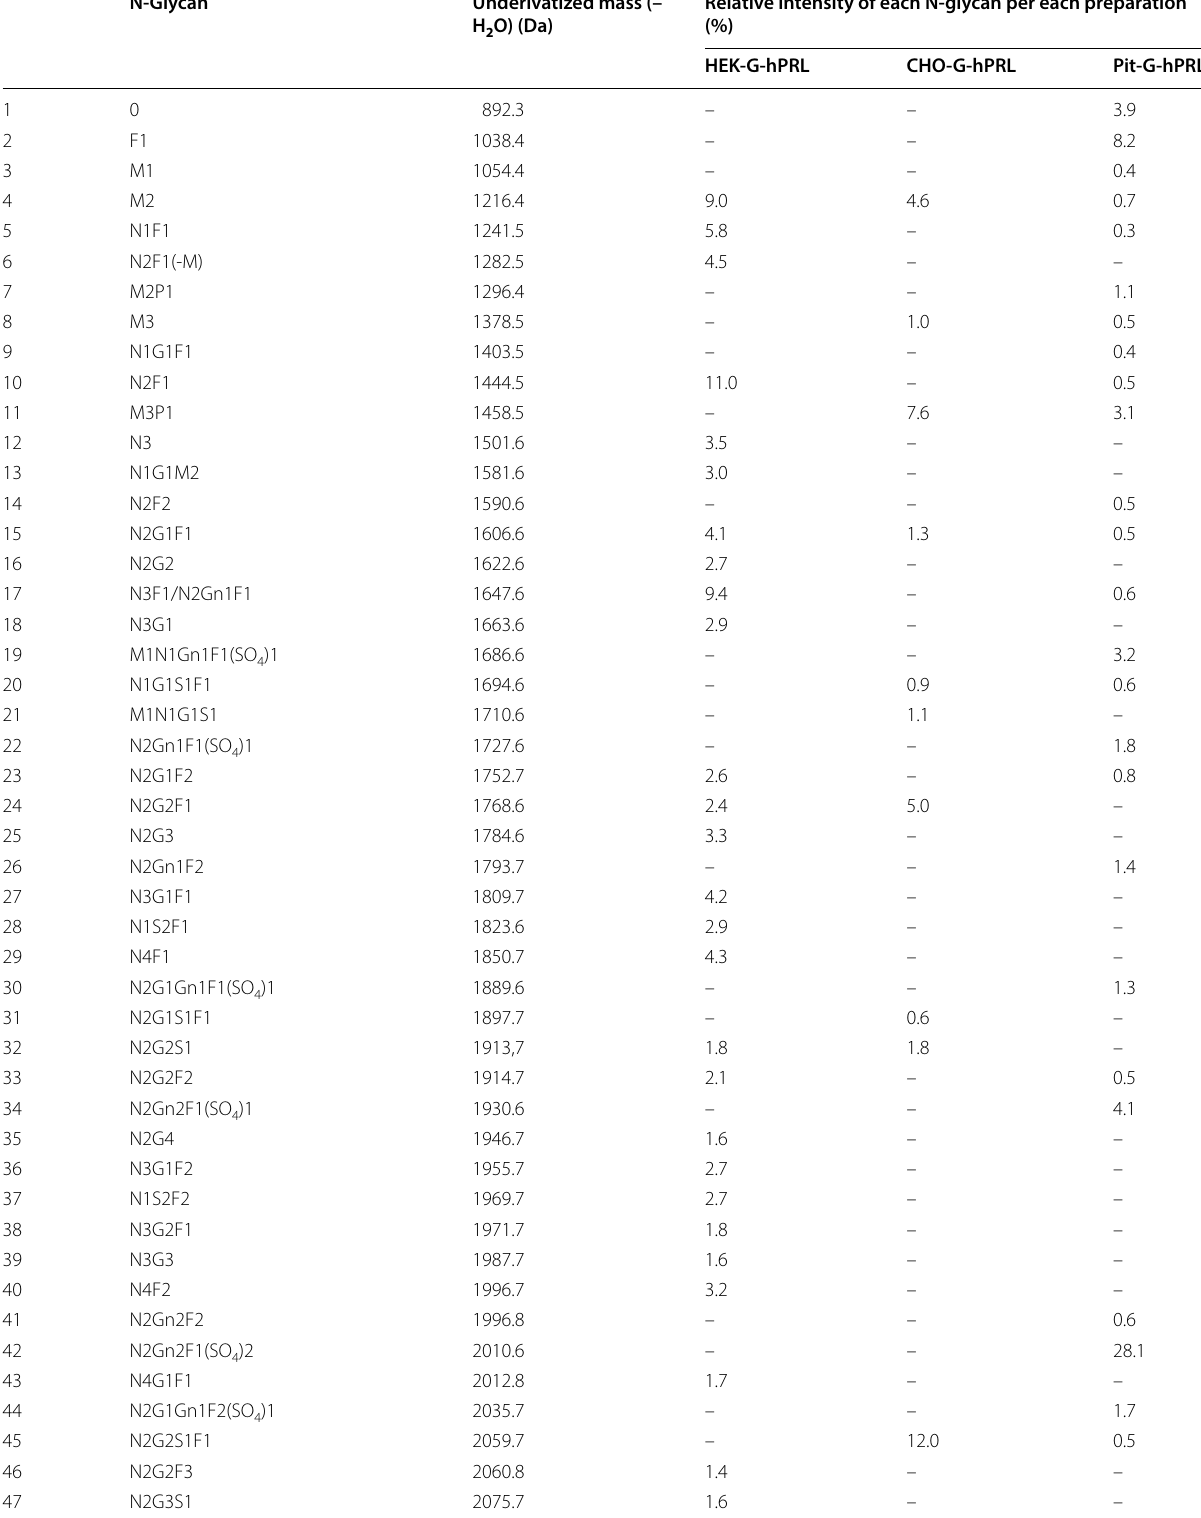
Table 1 Different N-glycan structures and relative intensities for the native and two recombinant preparations of